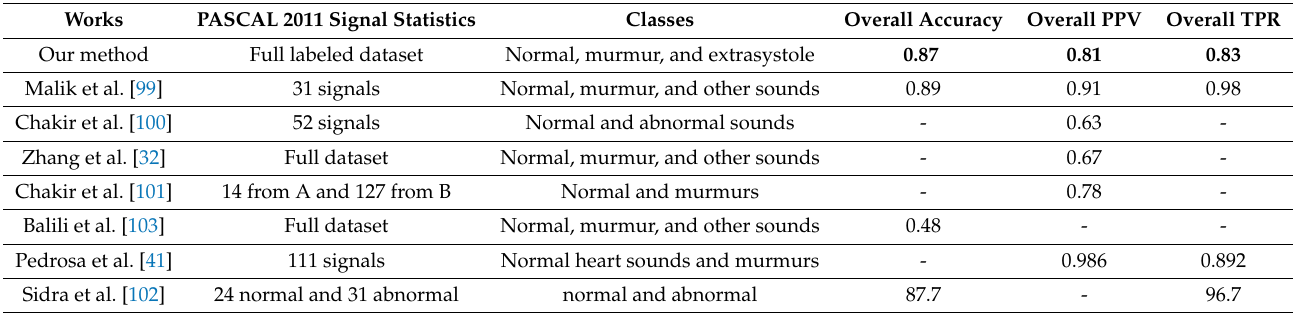
Table 8. An overview of our model results compared to that of some related works.